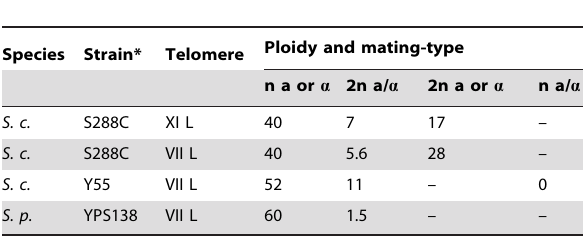
Table 1. Percentage URA3 repression at telomeres as measured by 5-FOA assay.